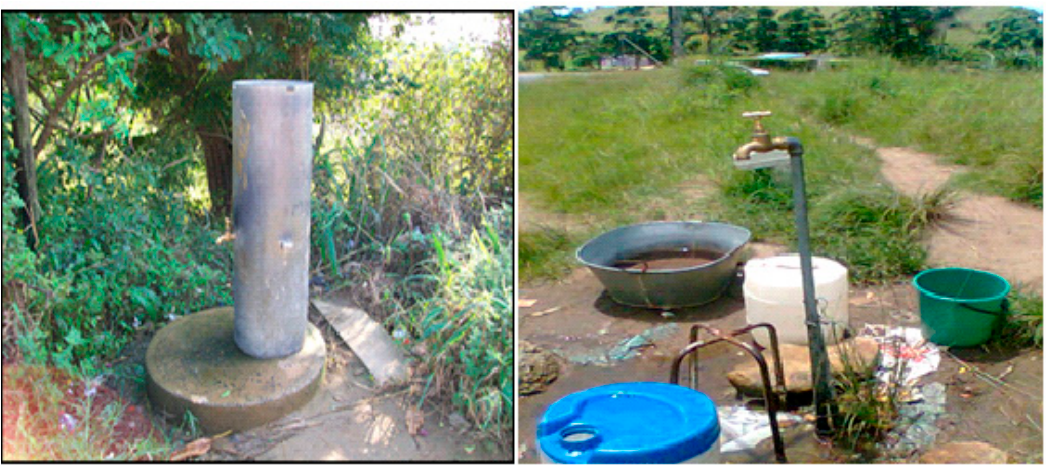
Figure 7. Different rural communal standpipes in Boboyi, Bomela and Gamalakhe supplying drinking water to households.